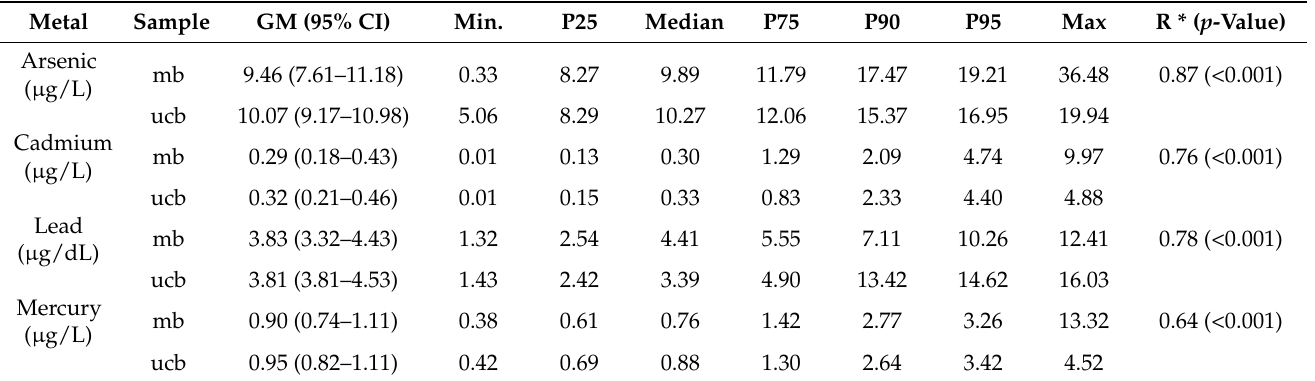
Table 1. Descriptive statistics for arsenic, cadmium, lead, and mercury concentrations in maternal and umbilical cord blood, Rio de Janeiro, Brazil,